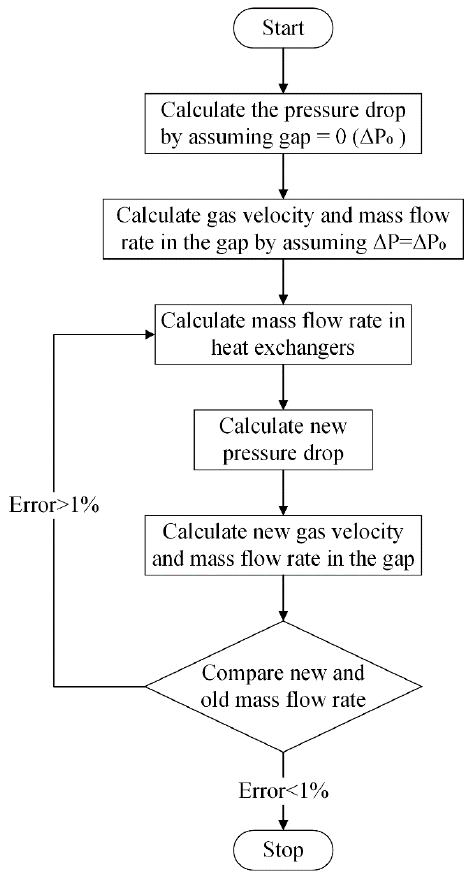
Figure 14. Flowchart of pressure drop correction based on the coupled model.